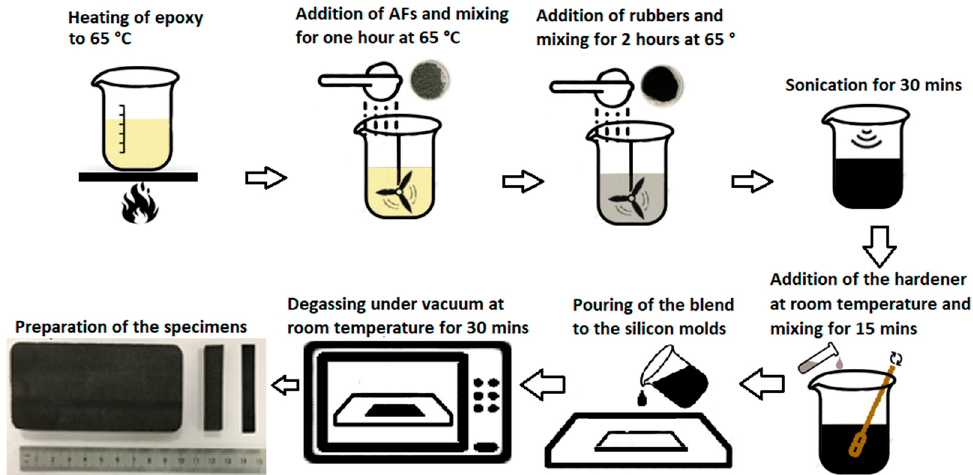
Figure 1. Manufacturing flow chart for the recycled EPDM rubbers modified epoxy-based composites [5].